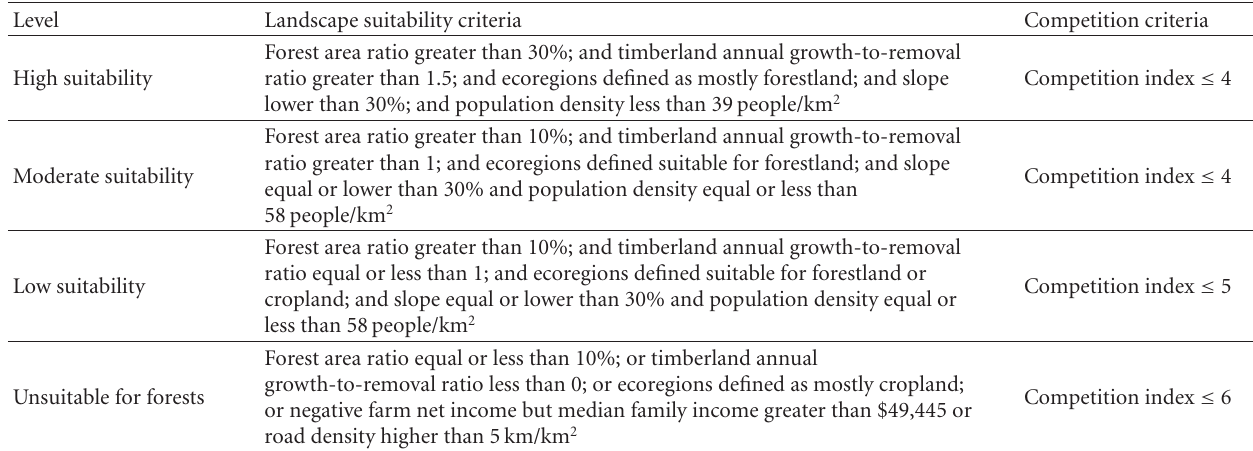
Table 5: Criteria for four levels of the combined landscape suitability and competition